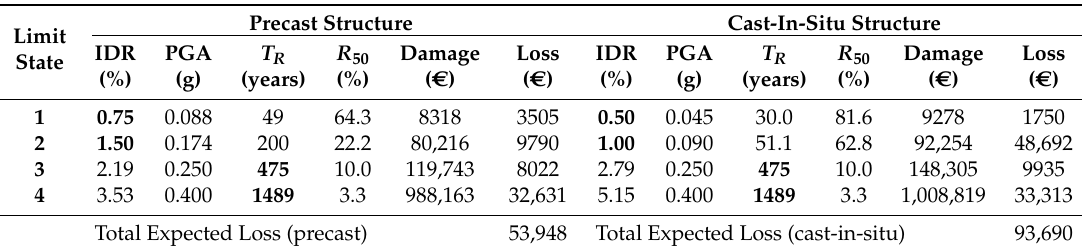
Table 7. Total expected losses.